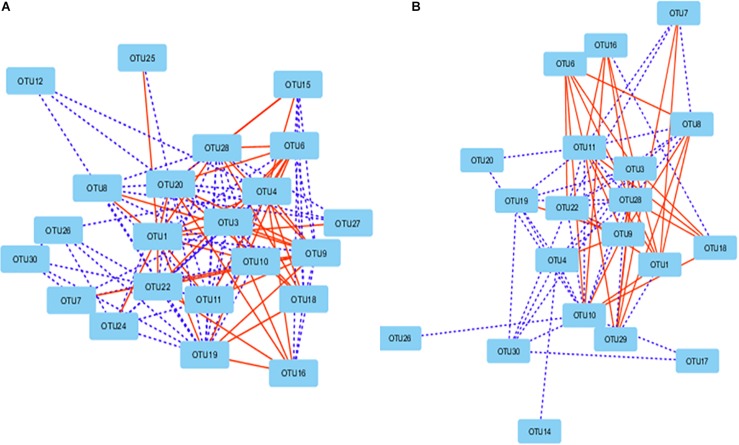
Correlation networks showing correlations between major OTUs (each representing ≥0.5% total sequences) in the rumen of the Control group (A) and both the plant bioactive lipid compound groups (B). Dotted lines indicate positive correlations, while solid lines represent negative correlations. The shorter the distance between two nodes, the stronger the correlation between them. See Supplementary Table S5 for the taxonomic assignment of the OTUs.